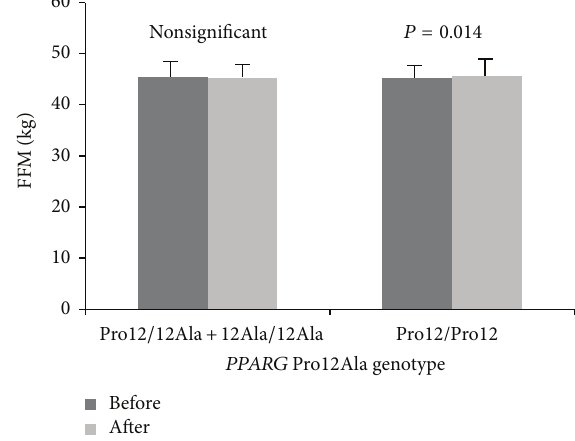
Figure 2: Changes in fat mass percentage observed in participants ( PPARG 12Ala carriers versus Pro12 homozygotes) before and after the completion of 12-week training program.